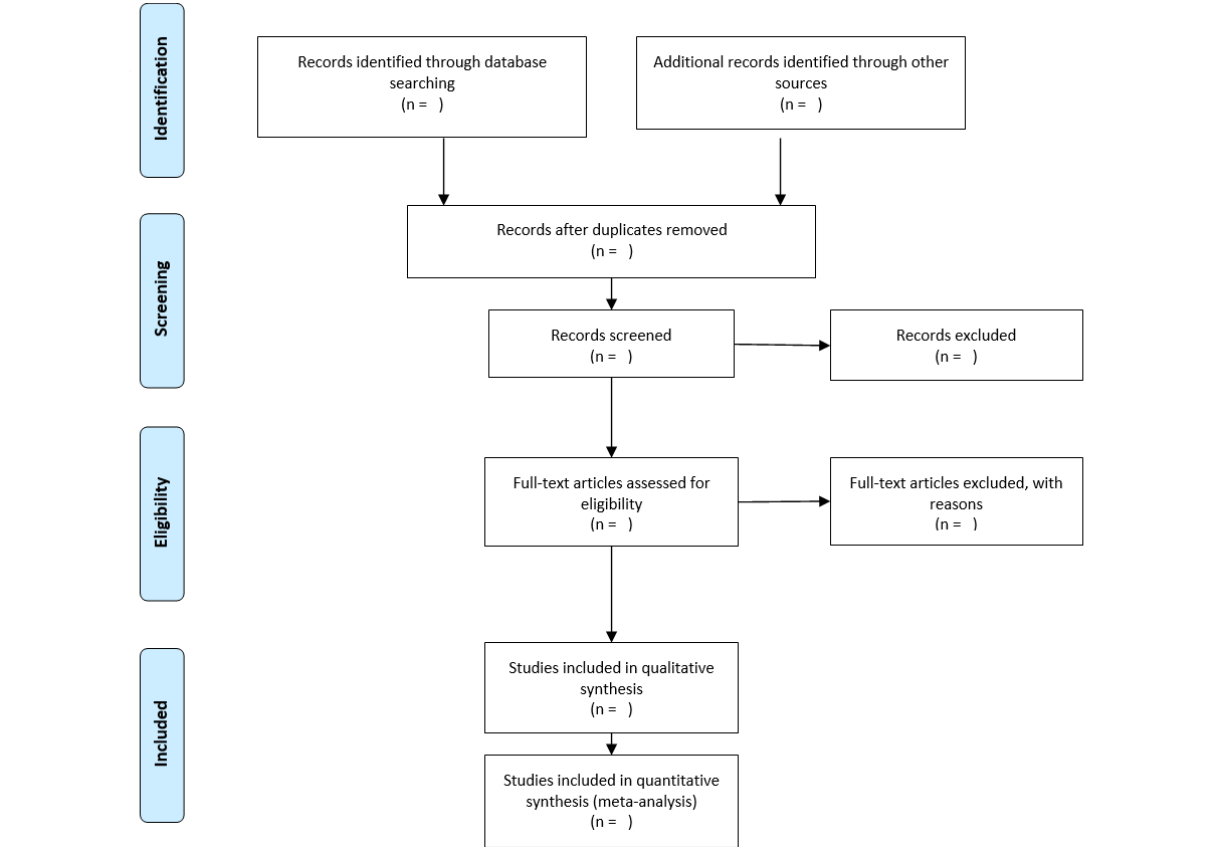
Figure 1. PRISMA flow-chart template of the search and selection